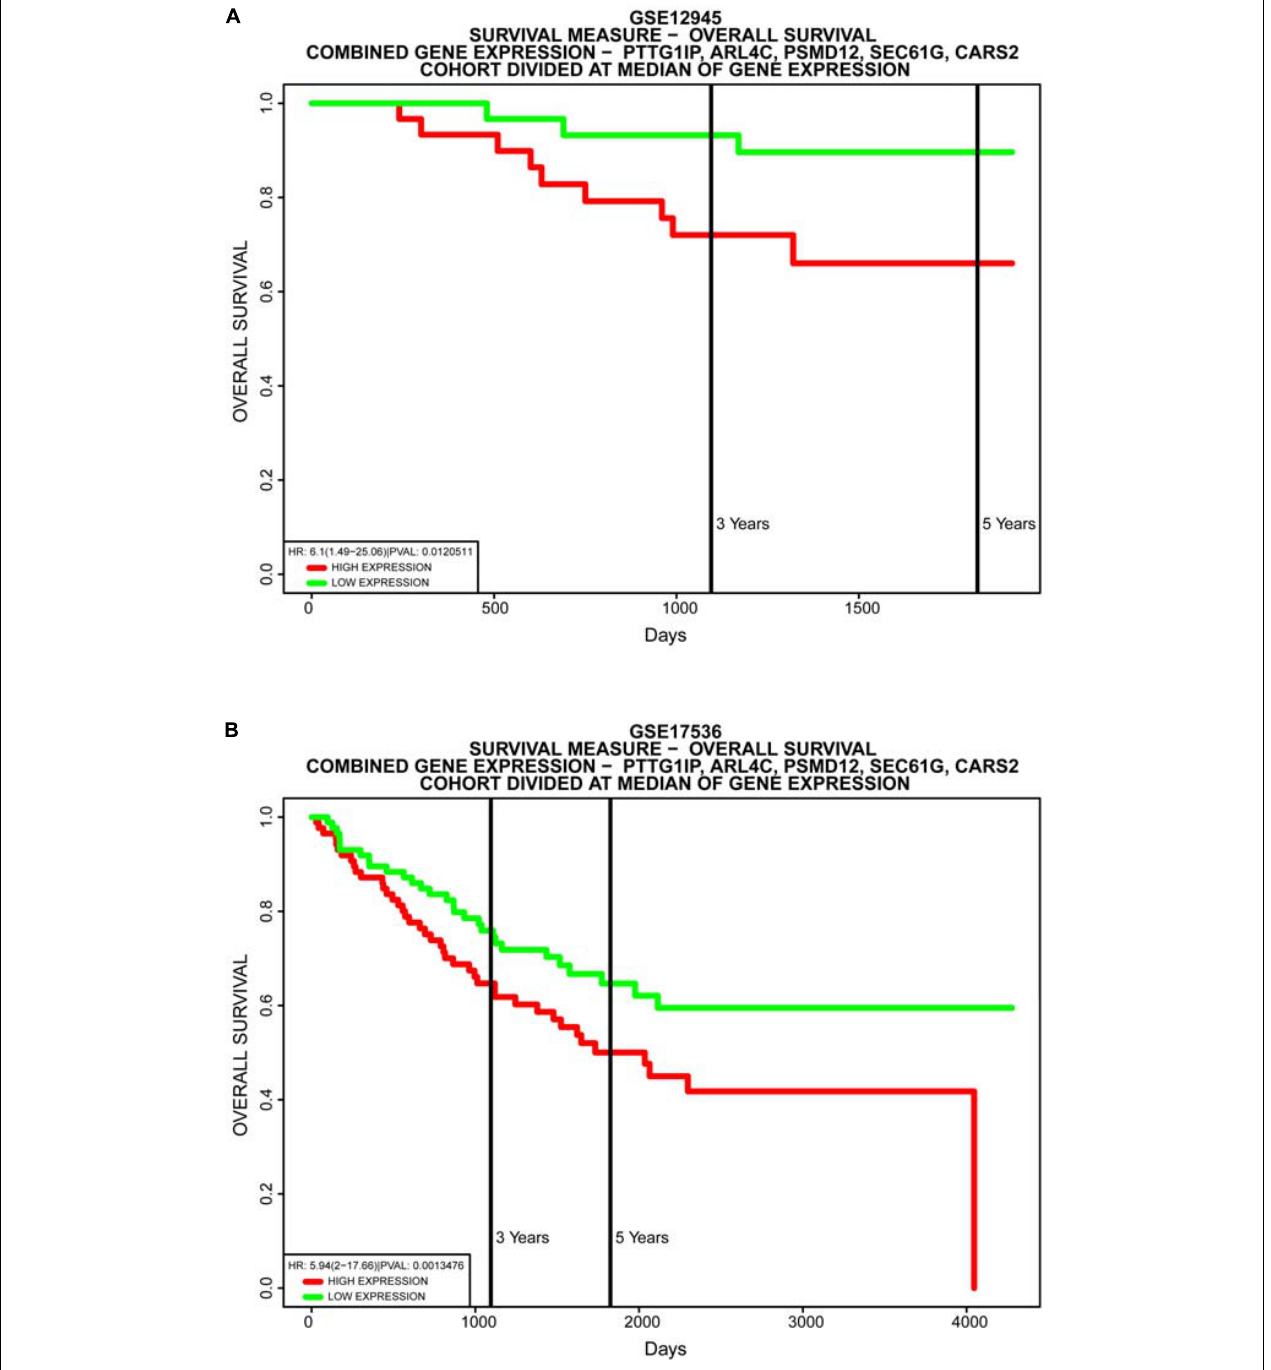
FIGURE 11 | Database validation of the model. Multiple gene survival analysis, from the PROGgeneV2 online tool. (A) GSE12945; (B) GSE17536. They all successfully validate the accuracy of our model, with P < 0.05.